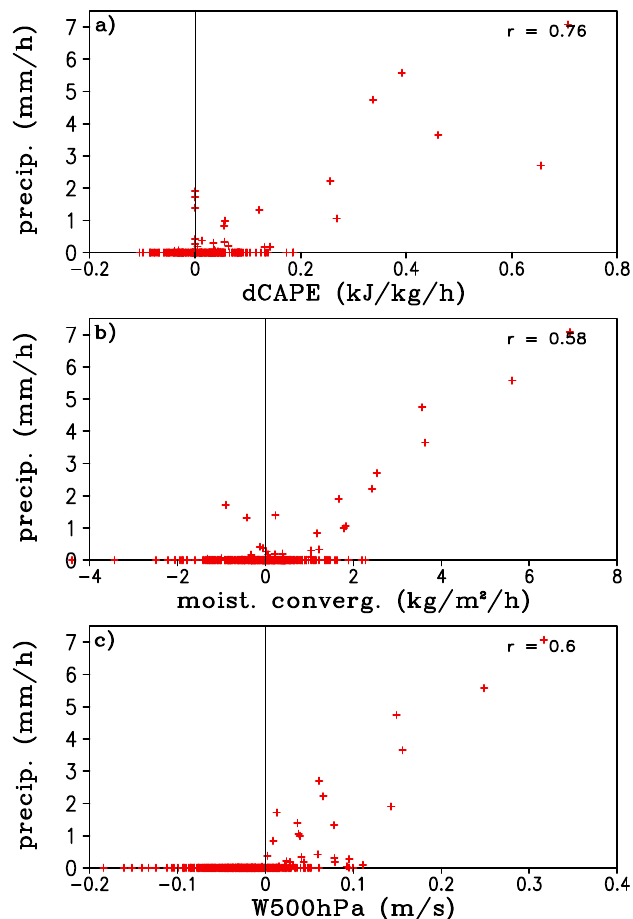
Figure 6. Scatter plots of precipitation rate (mm / h) against ( a ) large-scale convective available potential Figure 6. Same as Figure 5 but over the 75 km MC3E variational analysis domain. energy (CAPE) change (kJ / kg / h), ( b ) moisture convergence (kg / m 2 / h), and ( c ) vertical velocity at 500 hPa (ms − 1 ) over the 75 km MC3E variational analysis